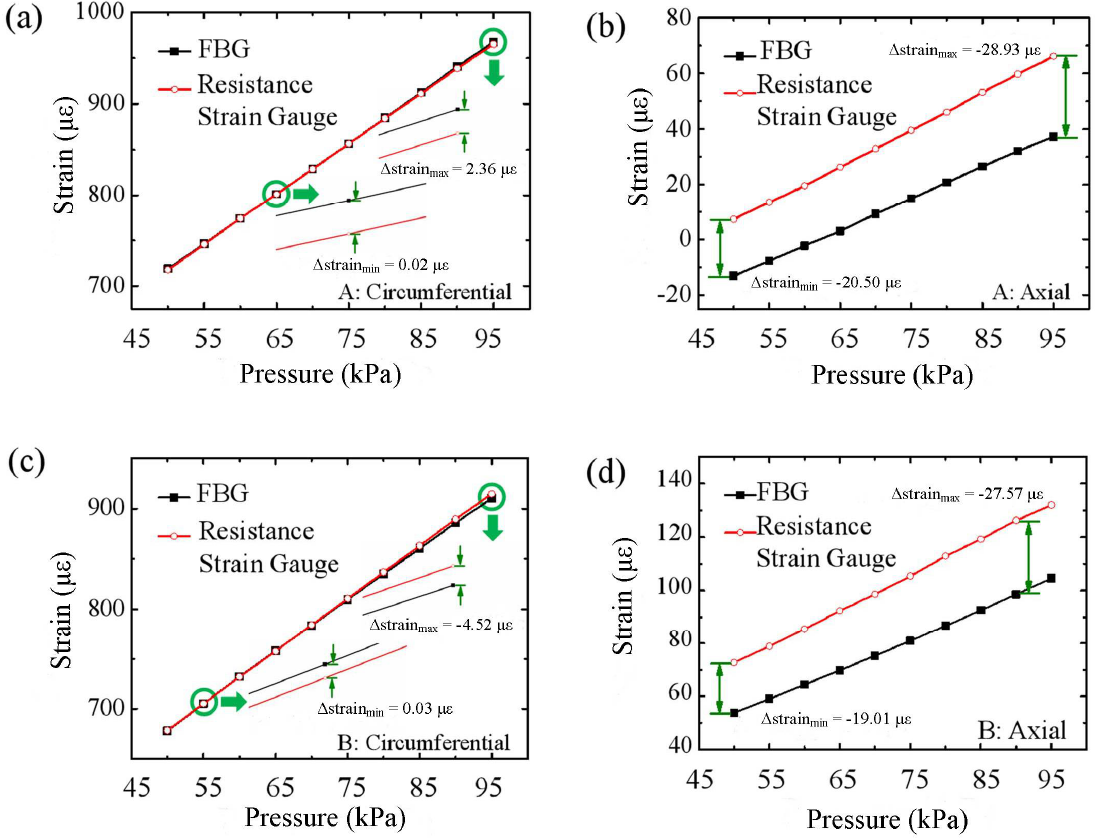
Figure 3. The strain values of Points A and B in the axial and circumferential direction at different pressures. ( a ) Point A: circumferential strain measurements; ( b ) Point A: axial strain measurements; ( c ) Point B: circumferential strain measurements; ( d ) Point B: axial strain measurements.